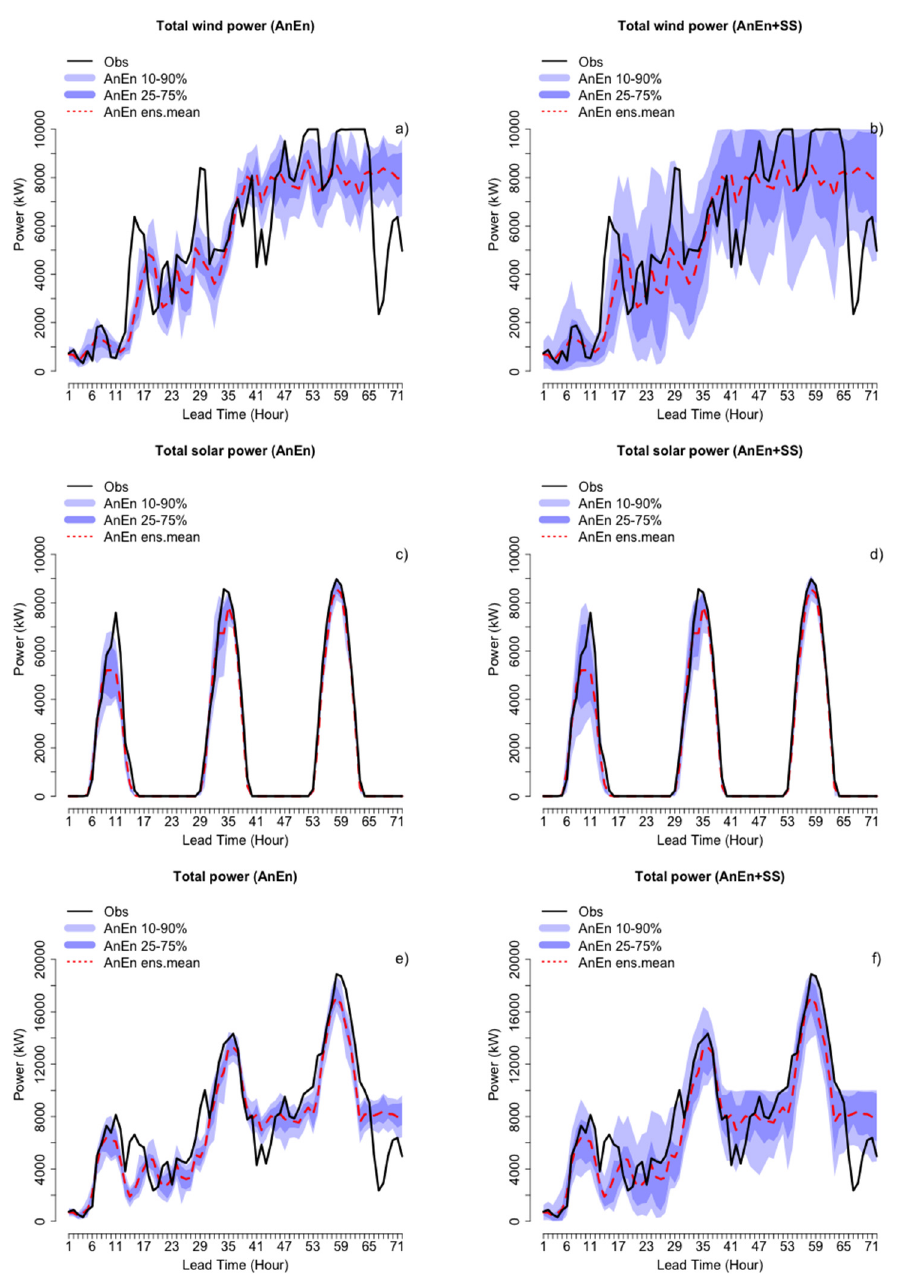
Figure 6. Example of analog ensemble (AnEn), ( a , c , e ) and AnEn + Schaake shuffle (SS), ( b , d , f ) ensemble forecast for total wind power ( a , b ), total solar power ( c , d ) and total wind + solar power ( e , f ). The shaded area indicates the 10th–90th and the 25th–75th quantile range, and the solid black line the verifying observations.